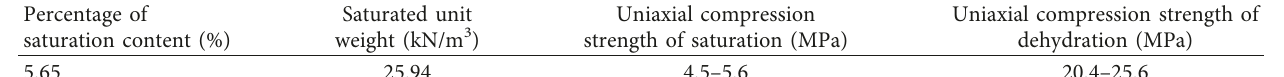
Table 1: The fundamental physical and mechanical properties of rock.